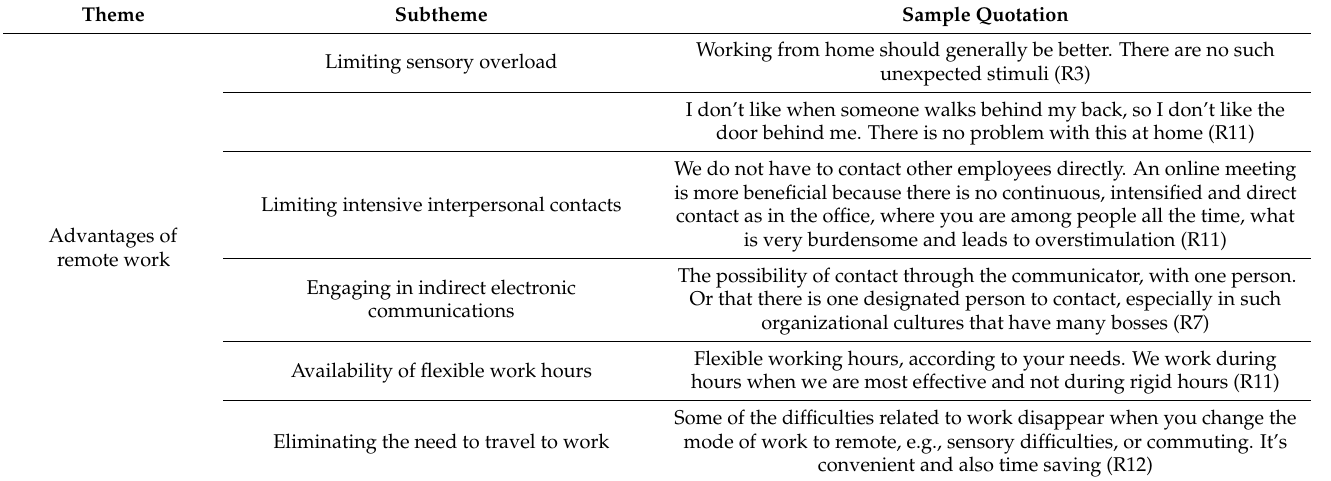
Table 2. Advantages and long-term challenges of remote work from the perspective of employees with